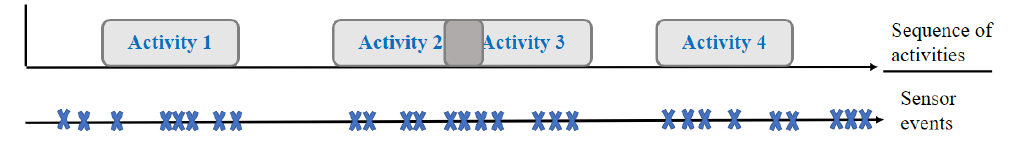
Figure 1. Sequence of activities.